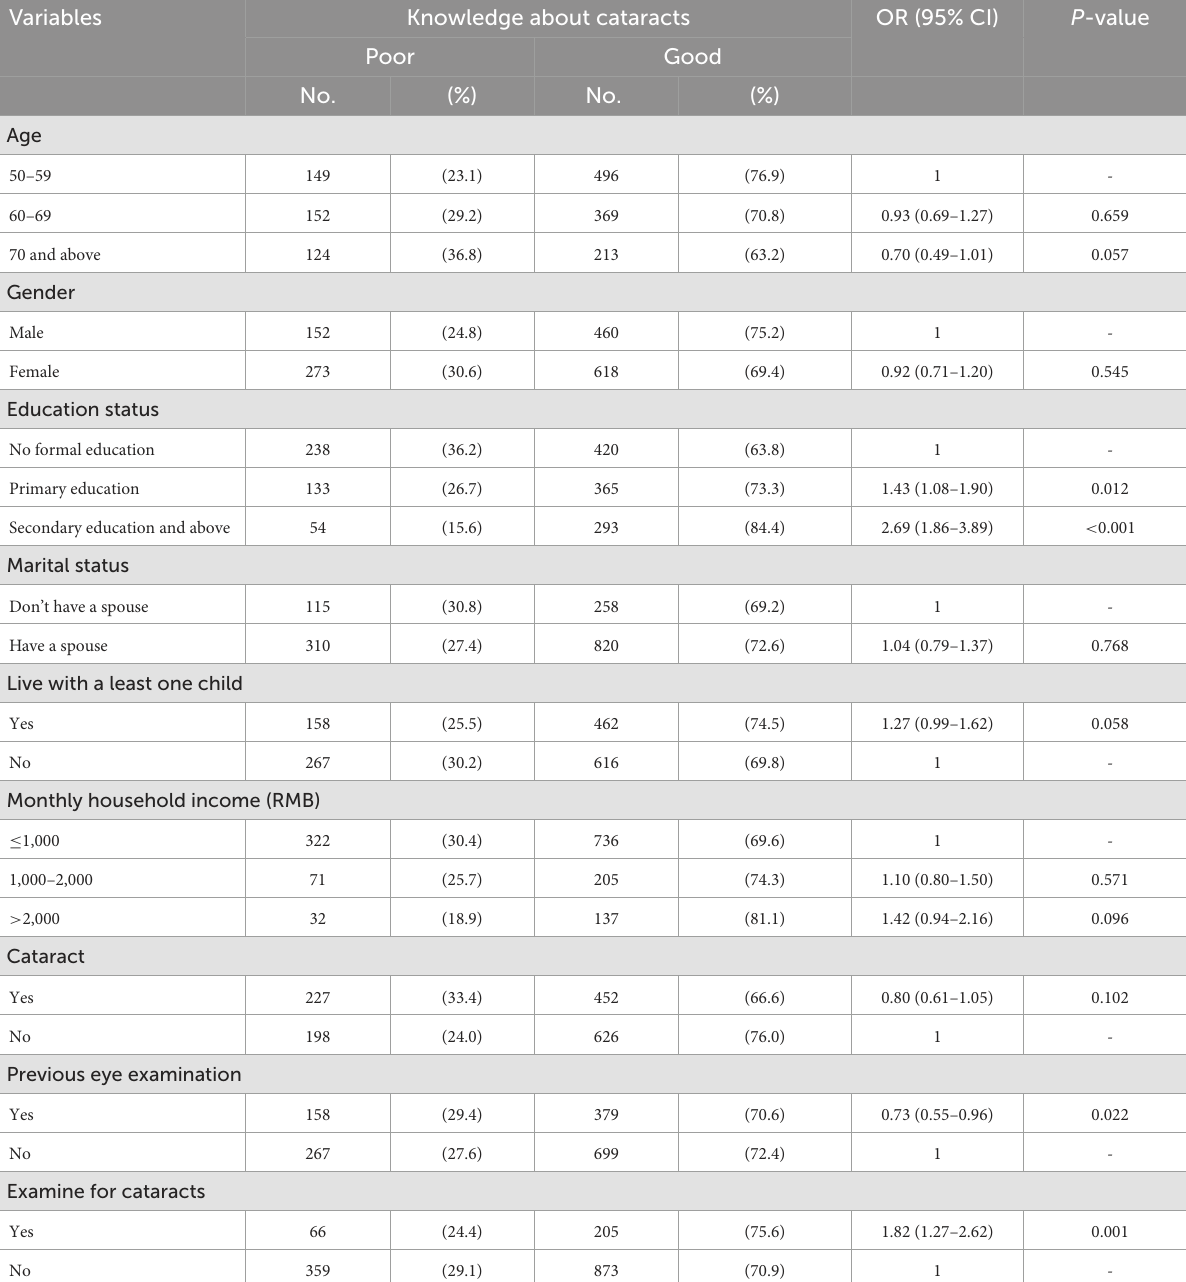
TABLE 3 Factors associated with knowledge about cataracts of adults aged 50 and above in rural western China 2021. Variables Knowledge about